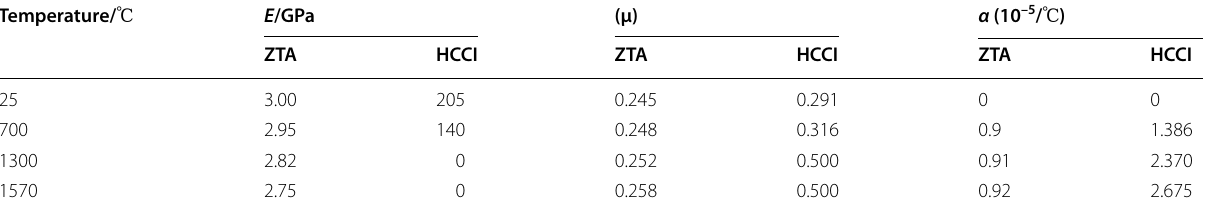
Table 1 Material